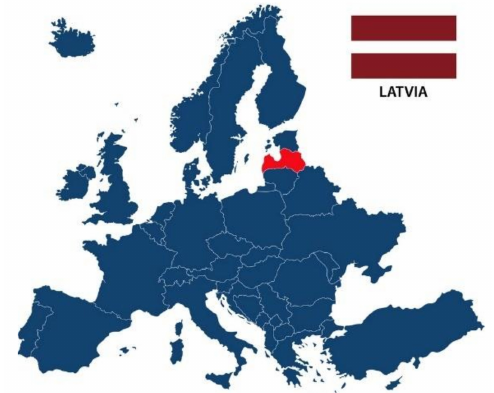
Figure 1. Geographical location of